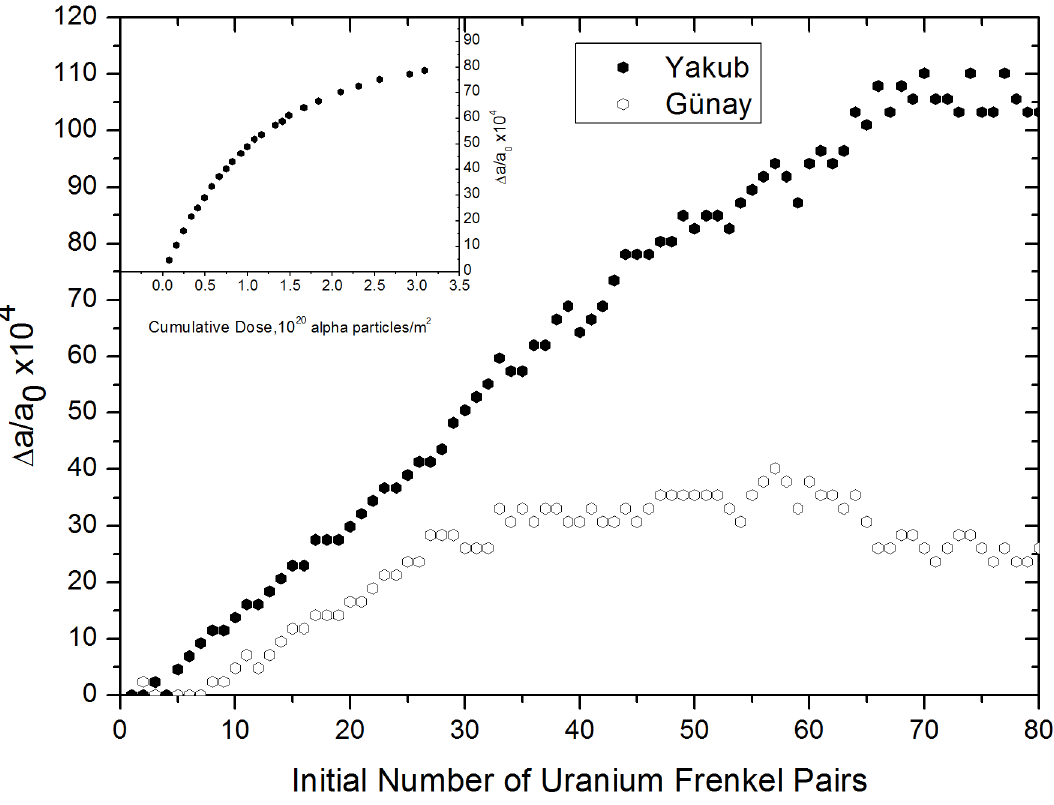
Fig 12. Relative lattice expansion versus number of uranium IFPs, calculated using the Yakub and Günay potentials. The inset was taken from Ref. 21 and shows experimental lattice expansion as a function of cumulative dose.